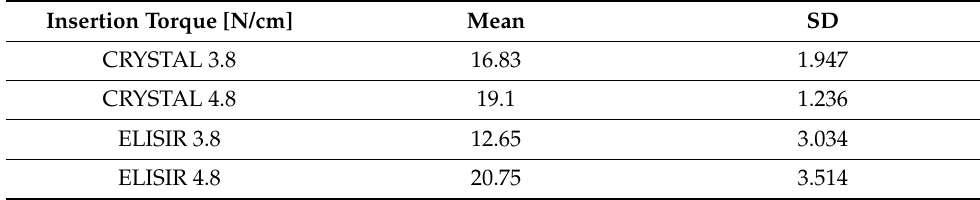
Table 1. Summary of Insertion Torque for the study groups. Insertion Torque